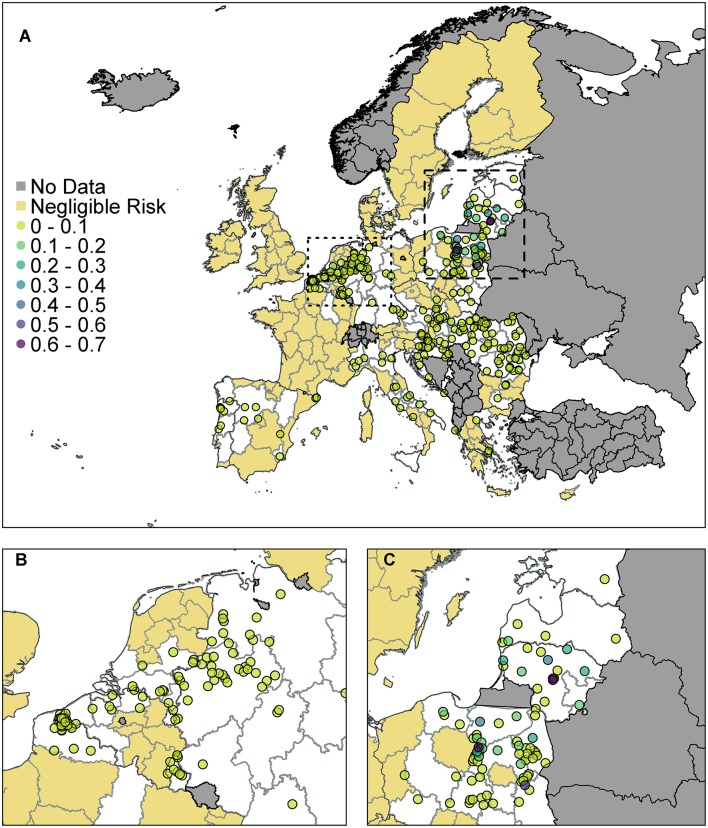
The probability of at least one infection of ASFV in pigs in 2019 from trade of live pigs at a farm level. In (A) all of Europe is plotted while in (B) the map is zoomed in to the dotted rectangle in (A) and in (C) the map is zoomed in to the dashed rectangle in (A). All farms indicated by a circle imported at least one infected animal in at least one simulation and the color indicates the probability that one or more susceptible pigs became infected. Countries in gray have insufficient data to complete the risk assessment. All farms in the regions with negligible risk either did not import any pigs or did not import any infected pigs. ©EuroGeographics for the administrative boundaries.